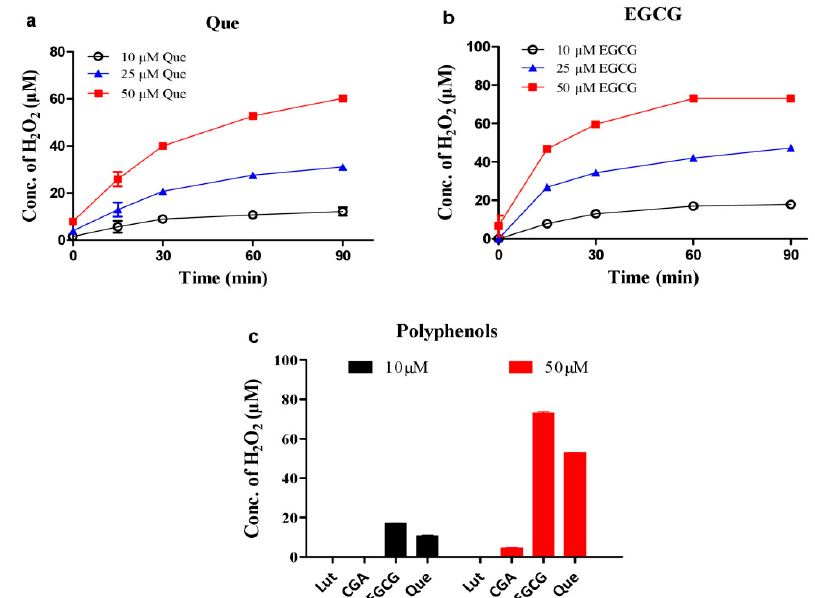
Figure 3. Influence of melatonin on ROS production from copper and other polyphenols. ( a ) EGCG. ( b ) Luteolin (Lut). ( c ) Chlorogenic acid (CGA). In 0.05 M PBS (pH 7.4), the examined polyphenol was 10 μ M, the Cu(II) was 1 μ M and the melatonin (MT) was 100 μ M. The reaction mixtures were incubated at 37 °C. Data are presented as the mean of two replicates; the error bar represents the range. In most data points, the range was smaller than the symbol.